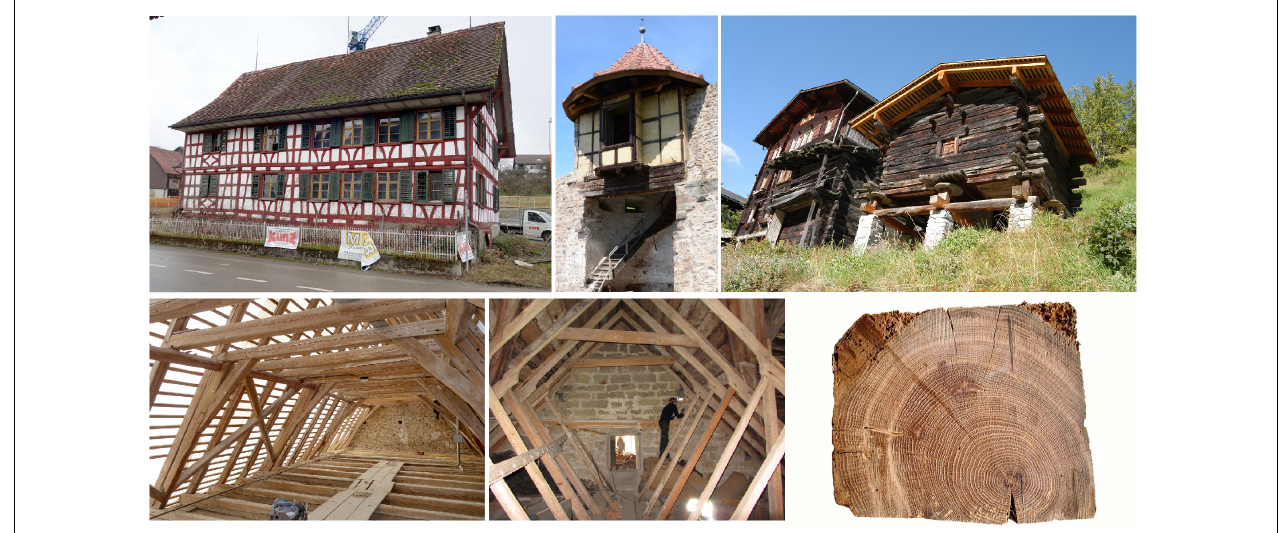
FIGURE 2 | Examples of type of buildings and material used to derive the felling dates from. Top: Half-timbered building in Sonterswil (Thurgau, Switzerland) from the 17th century. Tower of the town wall from Ribeauvillé (Alsace, France) from the 16th century. Log houses in the Lötschental Valley (Valais, Switzerland) from the 18th century. Below: Roof truss of the Chapelle Saint-Denis in Marmoutier (Alsace, France) from the 16th century. Roof truss from the church in Forshem, southwestern Sweden, with a nave from the 12th century and a chancel from the 13th century. Cross section of an oak beam from the Cathedral of Reims (France) from the 13th